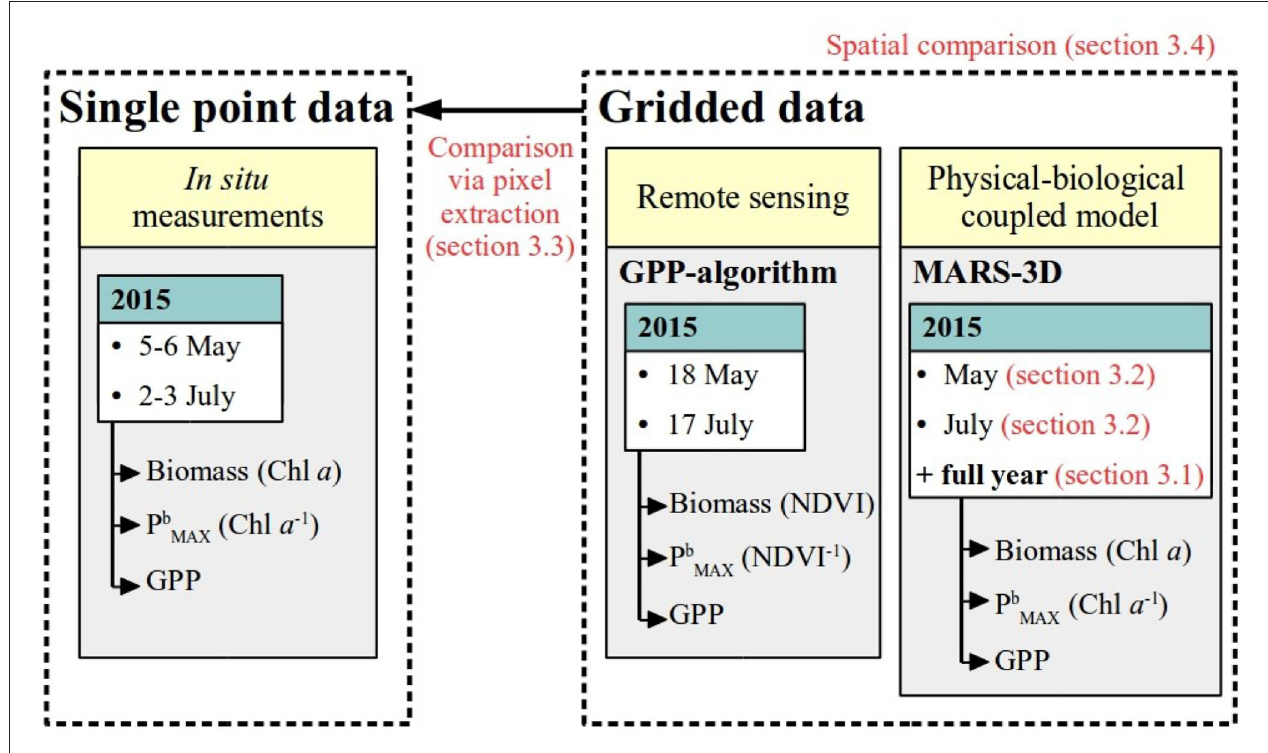
FIGURE 2 | Methods for MPB GPP estimation used in this study.